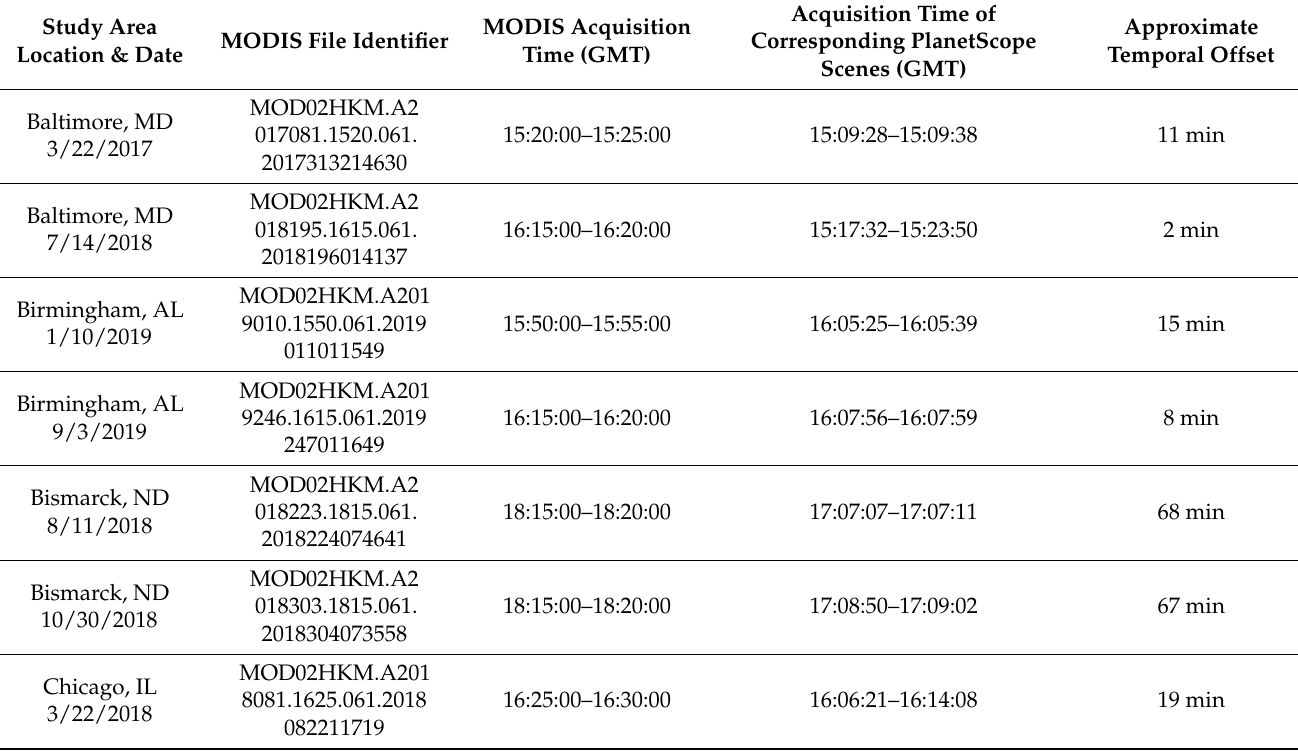
Table 2. PlanetScope and MODIS data acquired for this study. The first column lists the location and dates of the Dove- Classic (PS2) PlanetScope imagery acquired, with dates ranging from 3/22/2017 to 12/15/2019. The second column lists the MOD02HKM tile overlapping most closely to the acquired Planet data. The third and fourth column list the acquisition time of the respective PlanetScope and MODIS imagery, and the last column lists the approximate temporal offset between the two, which ranged from 2 min at the Baltimore, MD study area on 7/14/2018 to 70 min at the Chicago, IL study area on